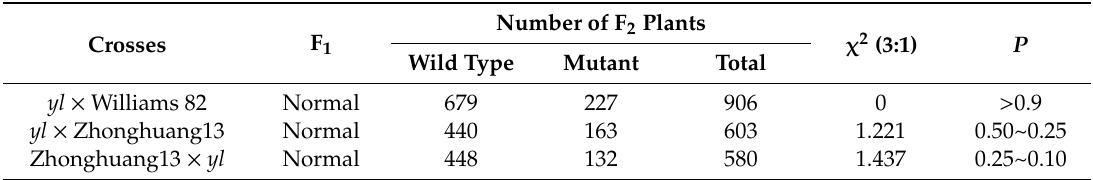
Table 1. Segregation pattern and chi-square tests for green / yellow leaves of F 2 progeny from the crosses between yl and Williams 82 or Zhonghuang 13.